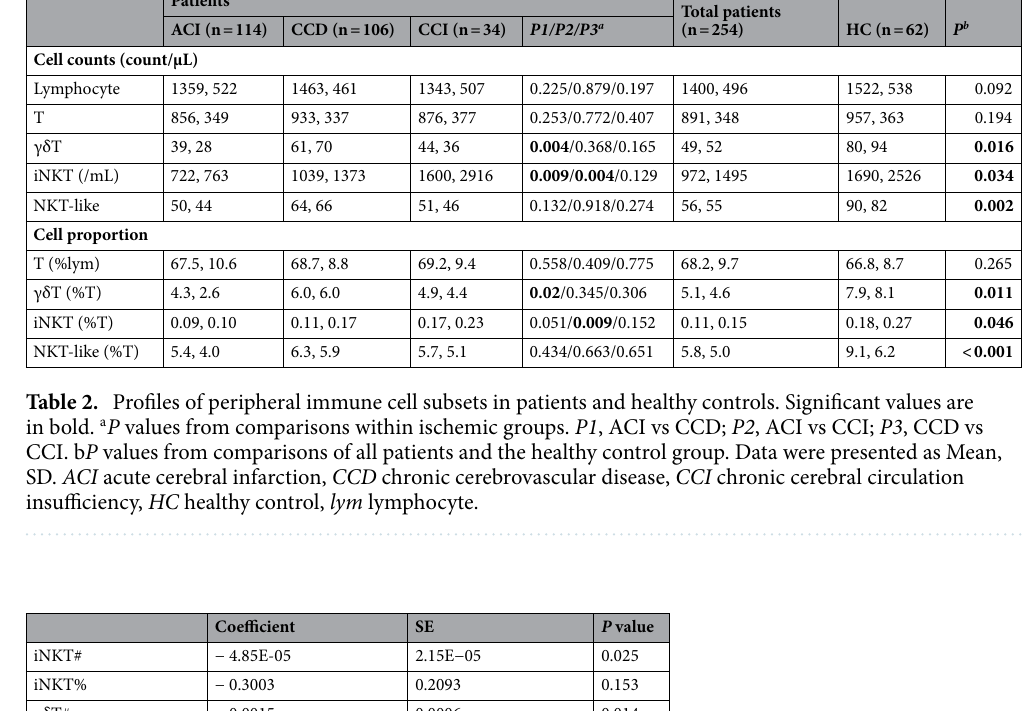
Coefficient SE P value